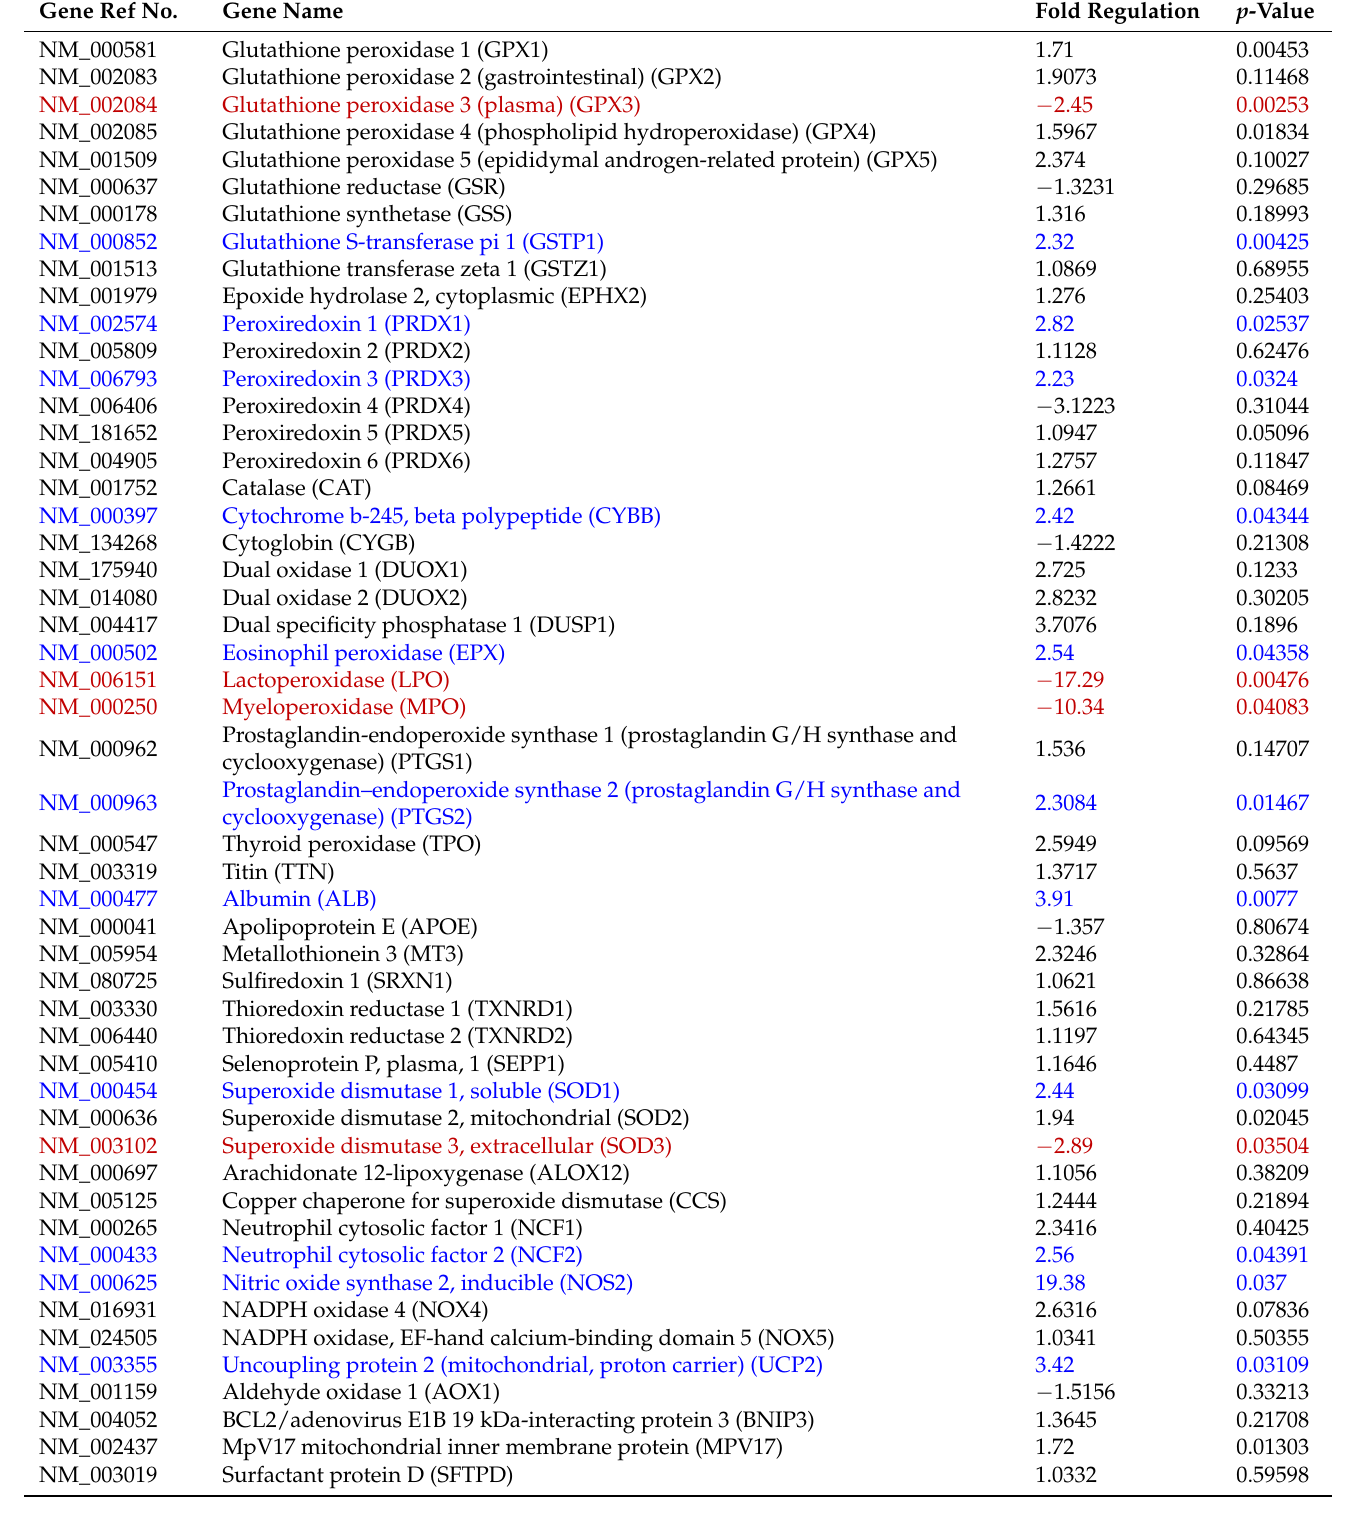
Table 2. Eighty-four oxidative-stress-related gene expressions in the NPs of patients with CRSwNP (the up- and downregulated genes with a p -value < 0.05 are highlighted in blue and red, respectively). Gene Ref